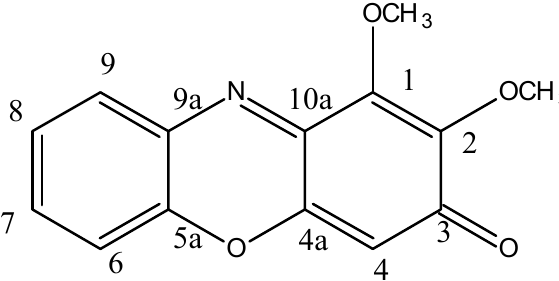
Figure 15. Natural product 1,2-dimethoxy-3 H -phenoxazin-3-one. The pigment is isolated as an orange solid: yield (40 mg, 20%), mp 148–150 °C. The 1 H NMR shows the distribution of protons signals between 1.0 and 8.0 ppm. Analysis of